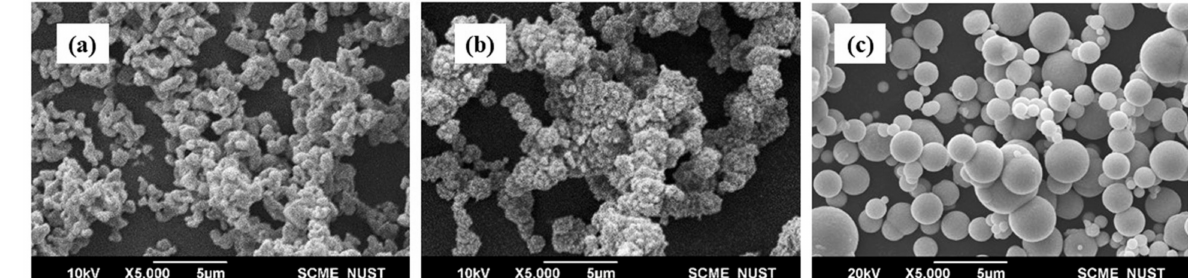
Figure 2. SEM images of ( a ) Cobalt ( b ) Nickel and ( c ) Iron particles.